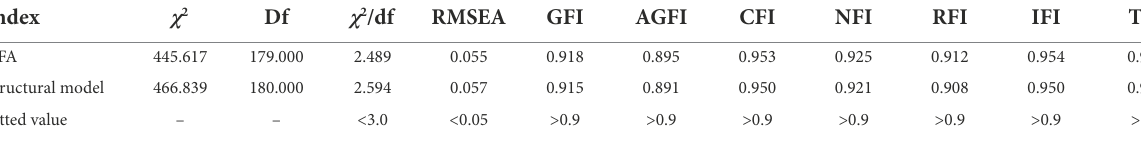
TABLE 2 The results of model fit measures.